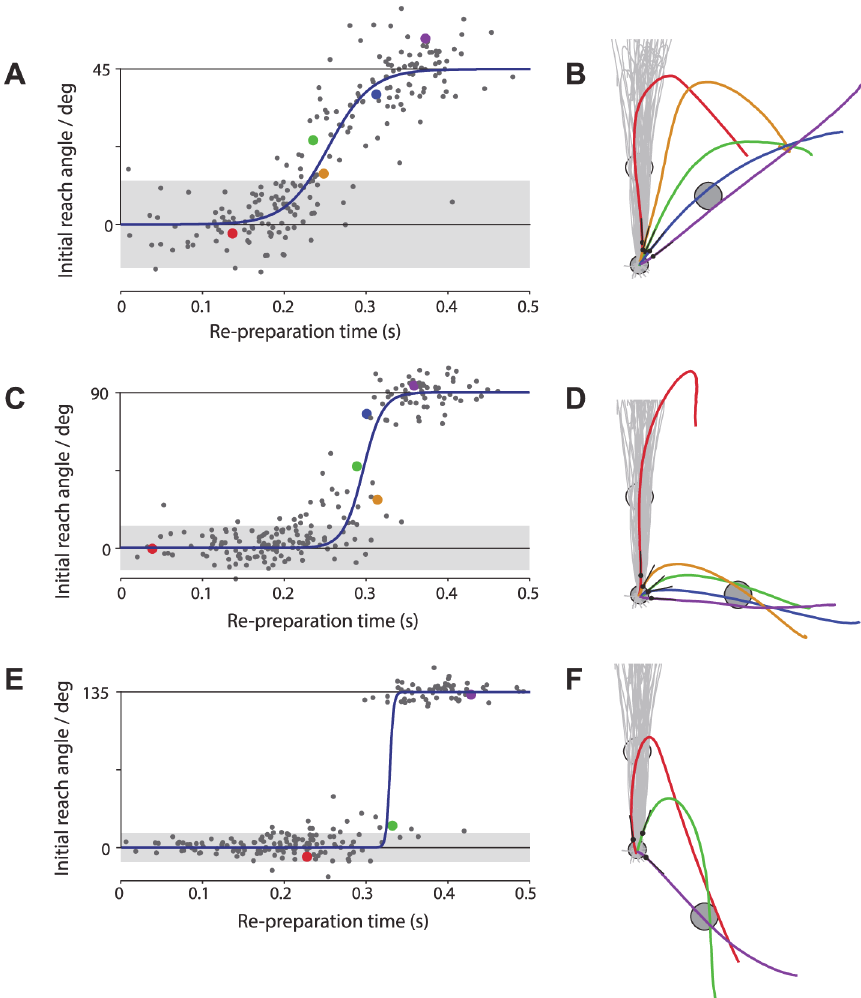
Fig 2. Behavior of a representative subject in Experiment 1. Left axes show the relationship between available re-preparation time (equal to the delay between target jump time and movement onset) and initial reach direction for 45° (A), 90° (C) and 135° (E) jumps. Each point represents a single jump trial. Solid lines indicate sigmoidal fits obtained by maximum likelihood estimation (see Methods). Shaded region indicates 95% confidence interval (1.96×standard deviation) for movement directions observed on non-jump trials. Right panels: trajectories of selected movements that were initiated in a direction intermediate between the original and post-jump target location following 45° (B), 90° (D) and 135° (F) jumps. Line colors indicate data point in corresponding plots to the left. Black circles indicate the position 100ms after movement onset at which point trajectory direction was calculated based on tangential velocity (adjoining black line). The original (pre-jump) target is located at the 12 o ’ clock position. Gray trajectories illustrate a sample of trajectories from non-jump